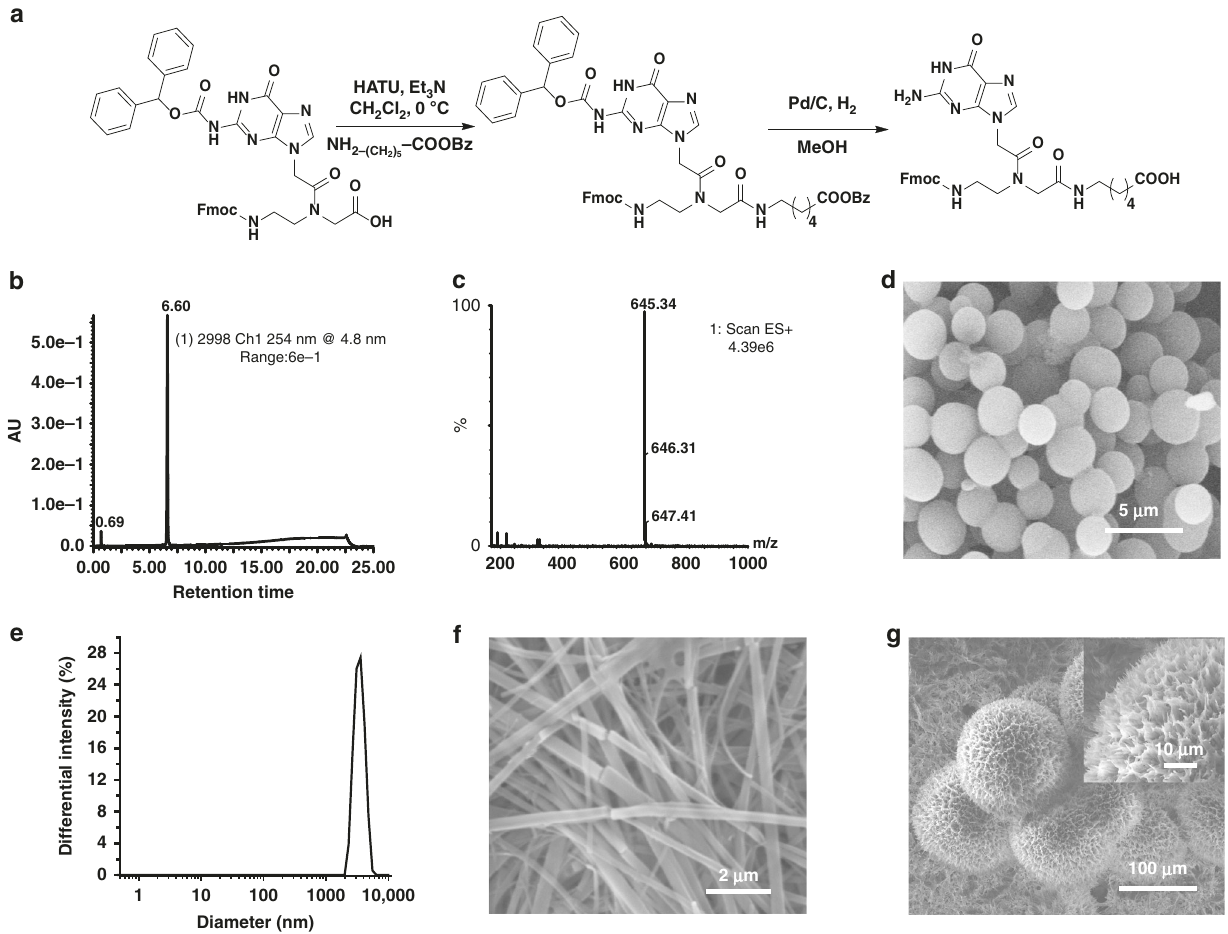
Fig. 1 Synthesis of the Fmoc-G-PNA conjugate and self-assembly characterization. a Schematic representation of the synthetic procedure. b LC pro fi le and c the corresponding mass spectrum. d SEM image of the microspheres. e DLS analysis of the spheres. The highest differential intensity was observed for a diameter of 3.39 μ m. f SEM image of the elongated nanoribbons. g SEM image of the microparticles formed in a hot aqueous